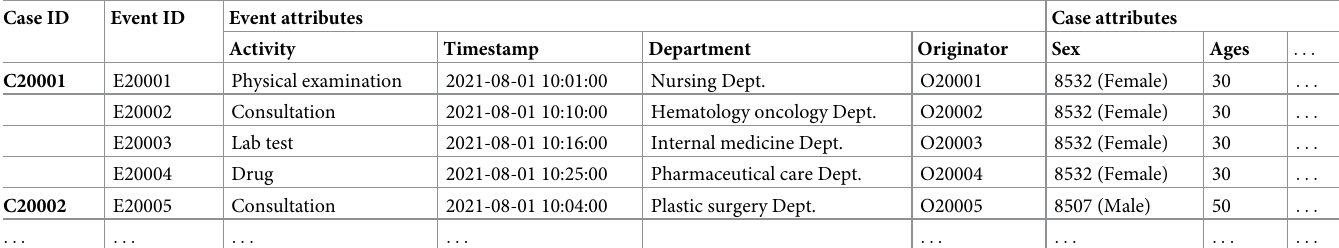
Table 3. An example of outpatient visit event logs.